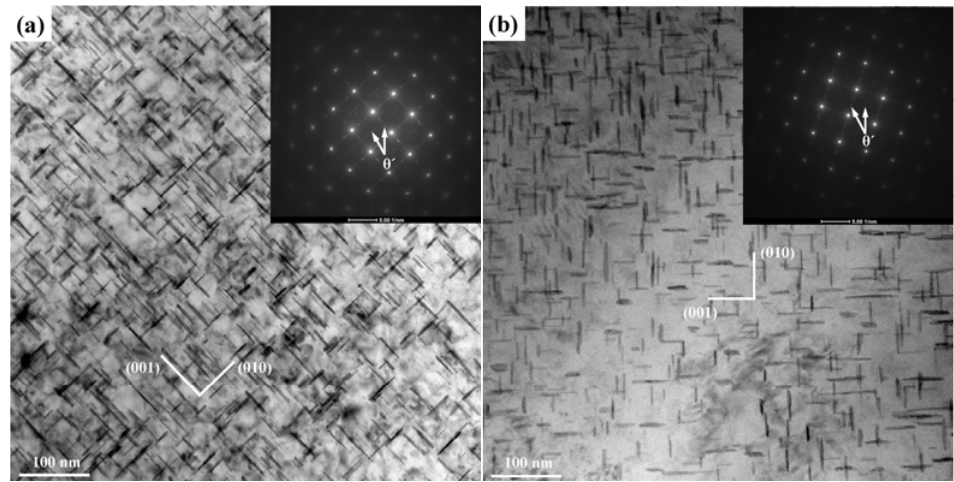
Figure 5. The TEM micrographs of 2519A aluminum alloys in thickness direction: ( a ) Surface layer; ( b ) Middle layer.